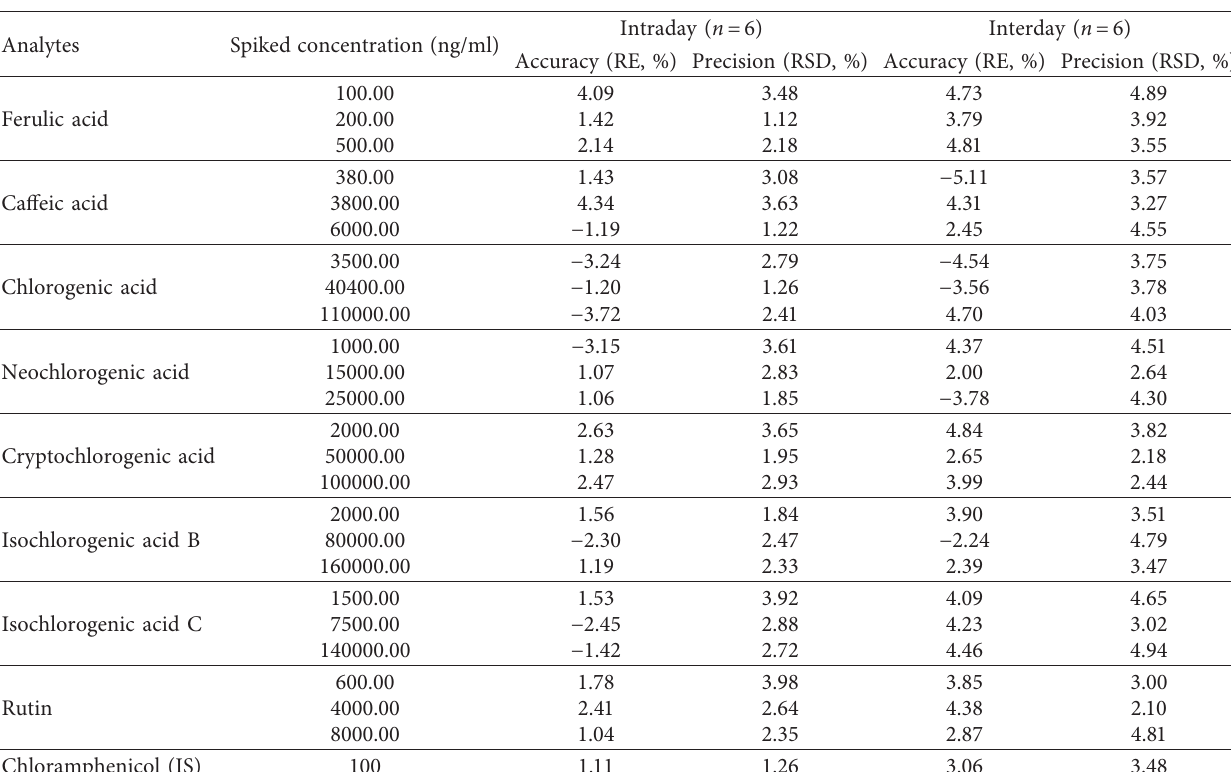
Table 3: Intraday and interday accuracy and precision of 8